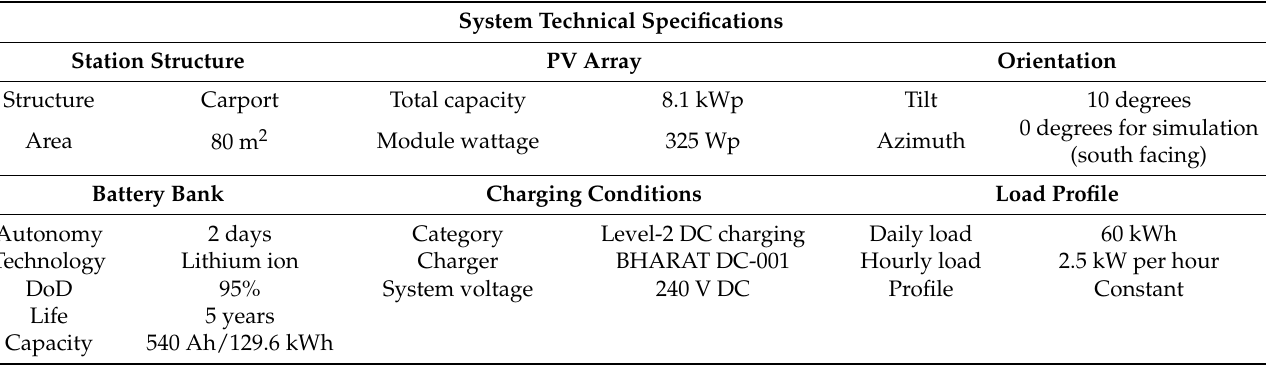
Table 5. Technical specifications of the optimized 8.1 kWp